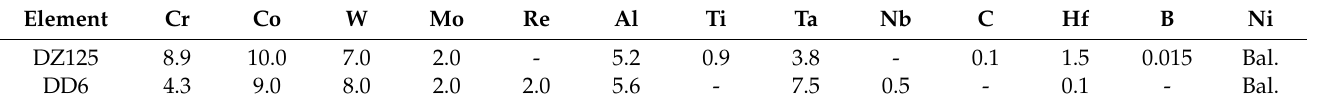
Table 1. The nominal compositions of the DZ125 and DD6